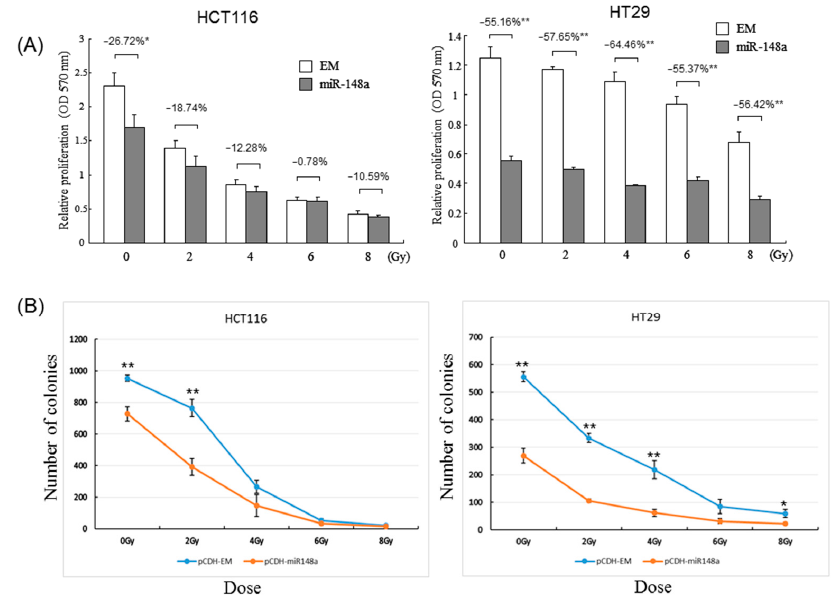
Figure 3. miRNA-148a modulated the proliferation and radiosensitivity of HCT116 and HT29 cells after irradiation. Both Figure 3. miRNA ‐ 148a modulated the proliferation and radiosensitivity of HCT116 and HT29 cells cell lines were transfected with a pCDH-miR148a plasmid (miRNA-148a) or a negative scrambled pCDH vector (EM). after irradiation. Both cell lines were transfected with a pCDH ‐ miR148a plasmid (miRNA ‐ 148a) or miR-148a overexpression enhanced the inhibitory effect of cell proliferation ( A ) and colony formation ( B ) after 2-, 4-, 6-, and a negative scrambled pCDH vector (EM). miR ‐ 148a overexpression enhanced the inhibitory effect 8-Gy irradiation (N = 3; * p < 0.05; ** p < 0.001). of cell proliferation ( A ) and colony formation ( B ) after 2 ‐ , 4 ‐ , 6 ‐ , and 8 ‐ Gy irradiation (N = 3; * p < 0.05; ** p < 0.001).